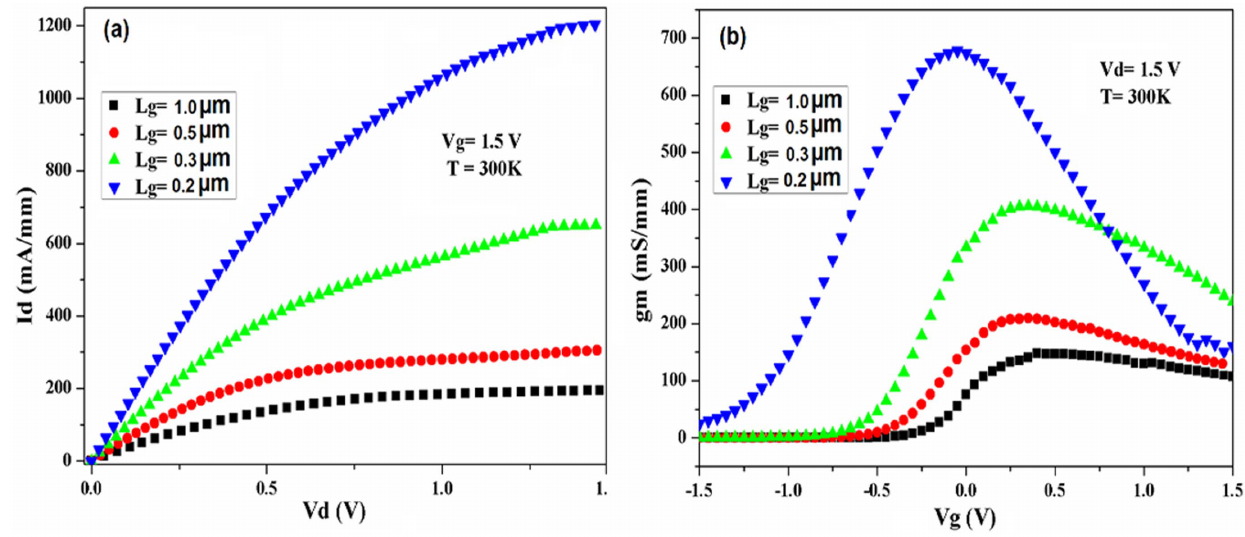
Figure 7. I d -V d characteristics (a) and Transconductance vs V g variation (b) of the devices for different L g . doi:10.1371/journal.pone.0082731.g007 PLOS ONE |